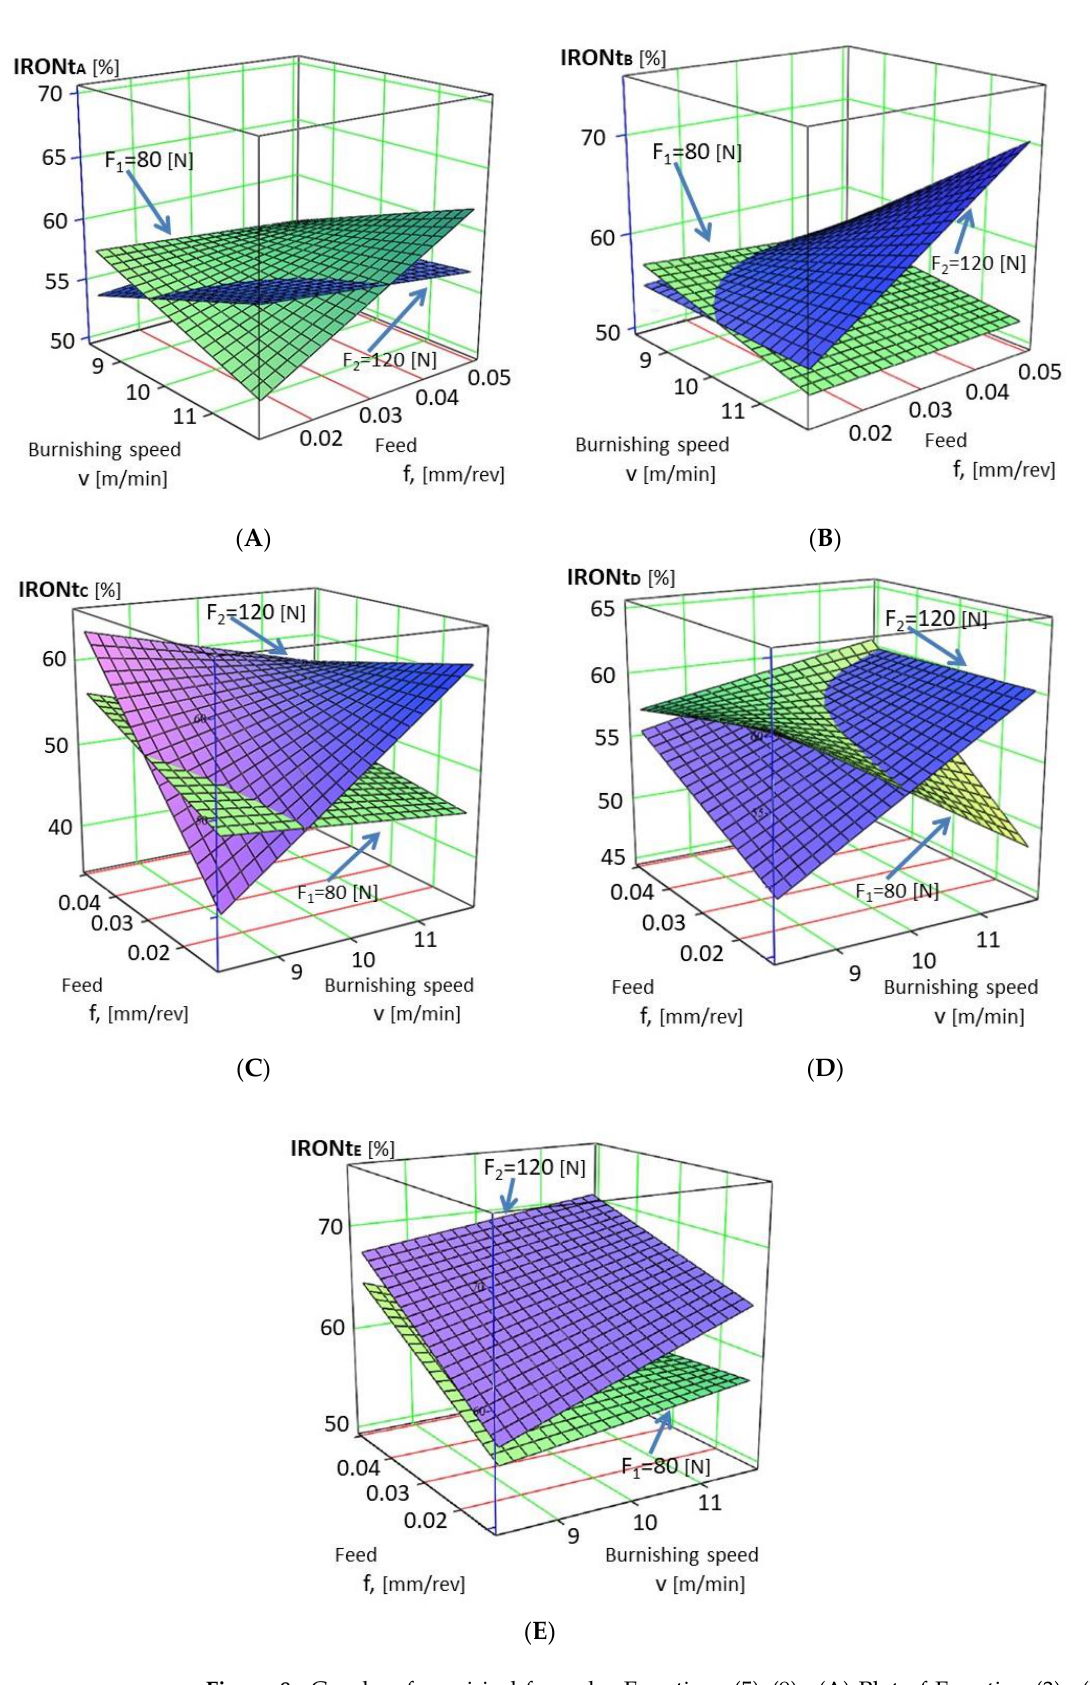
Figure 8. Graphs of empirical formulas Equations (5) – (9). ( A ) Plot of Equation (3). ( B ) Plot of Equation (4). ( C ) Plot of Equation (5). ( D ) Plot of Equation (6). ( E ) Plot of Equation (7).